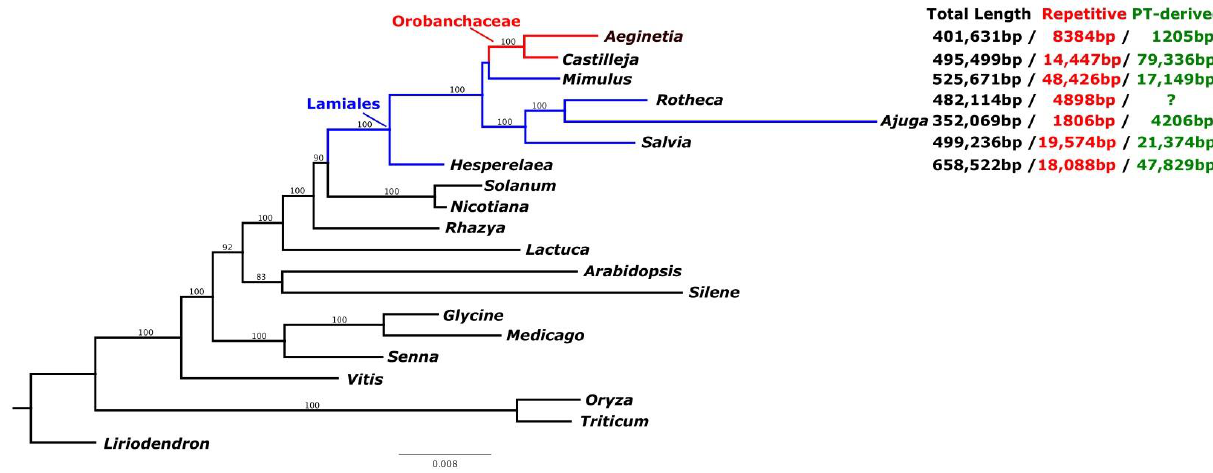
Figure 2. Cladogram of species included in the study. Topology was based on the ML tree generated concatenated MT genes listed in Table S6. Genome size, amount of plastid-like and repetitive DNA in seven Limiales species. Blue branches and red branches indicate Lamiales and Orobanchaceae species, respectively.